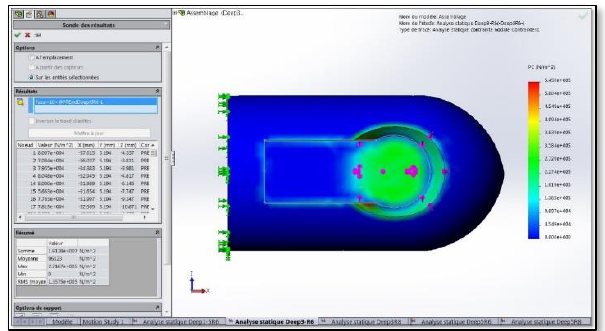
Figure 8. FEA simulation of the pressure distribution on the Deep3R6 sensor